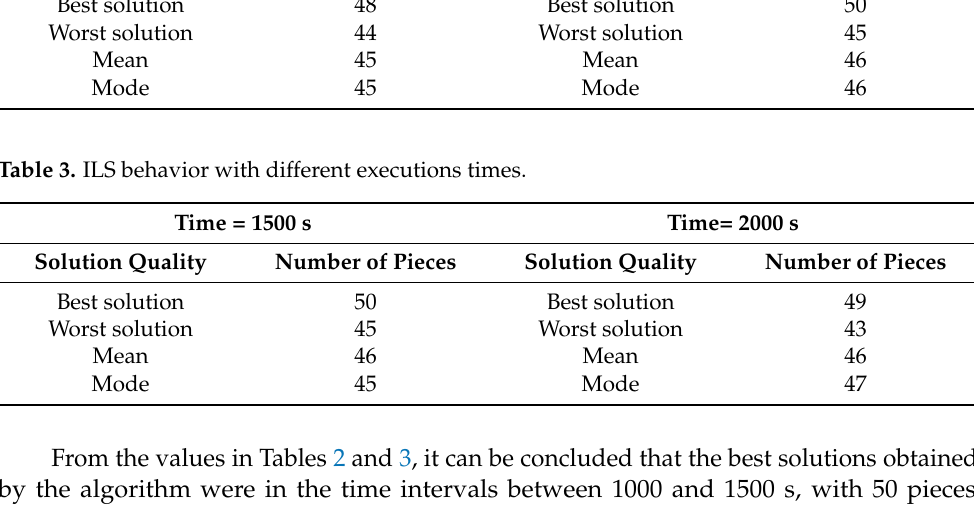
Table 2. ILS behavior with different executions times.